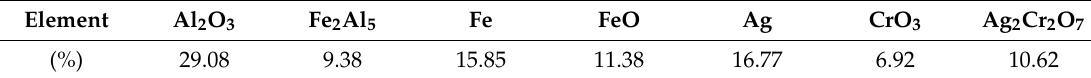
Figure 1. XRD analysis of the polycarbonate waste used. Table 3. Crystalline phases of the disc waste used.